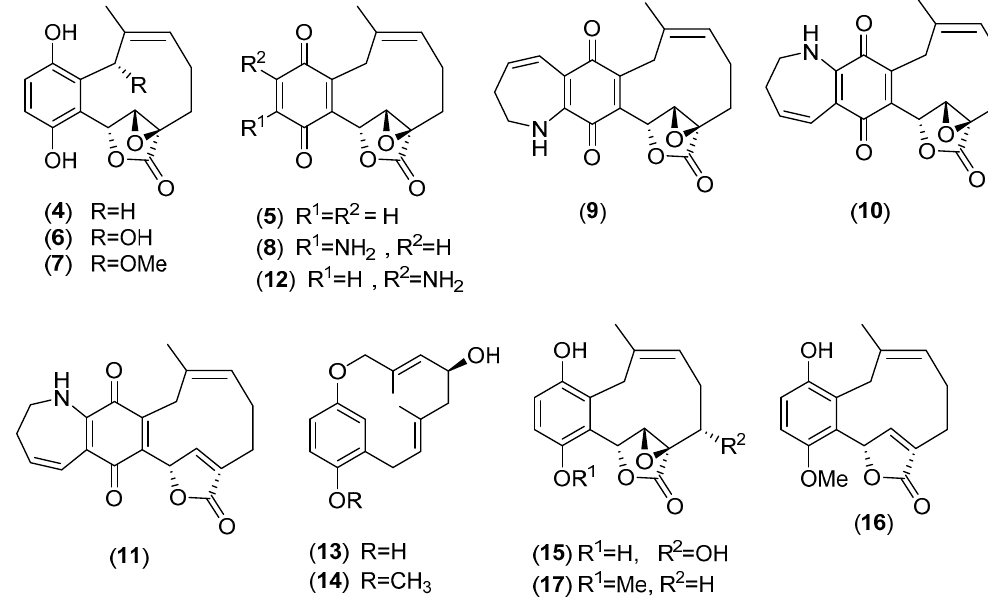
Figure 4. Chemical structures of selected compounds isolated from Ampulloclitocybe clavipes.